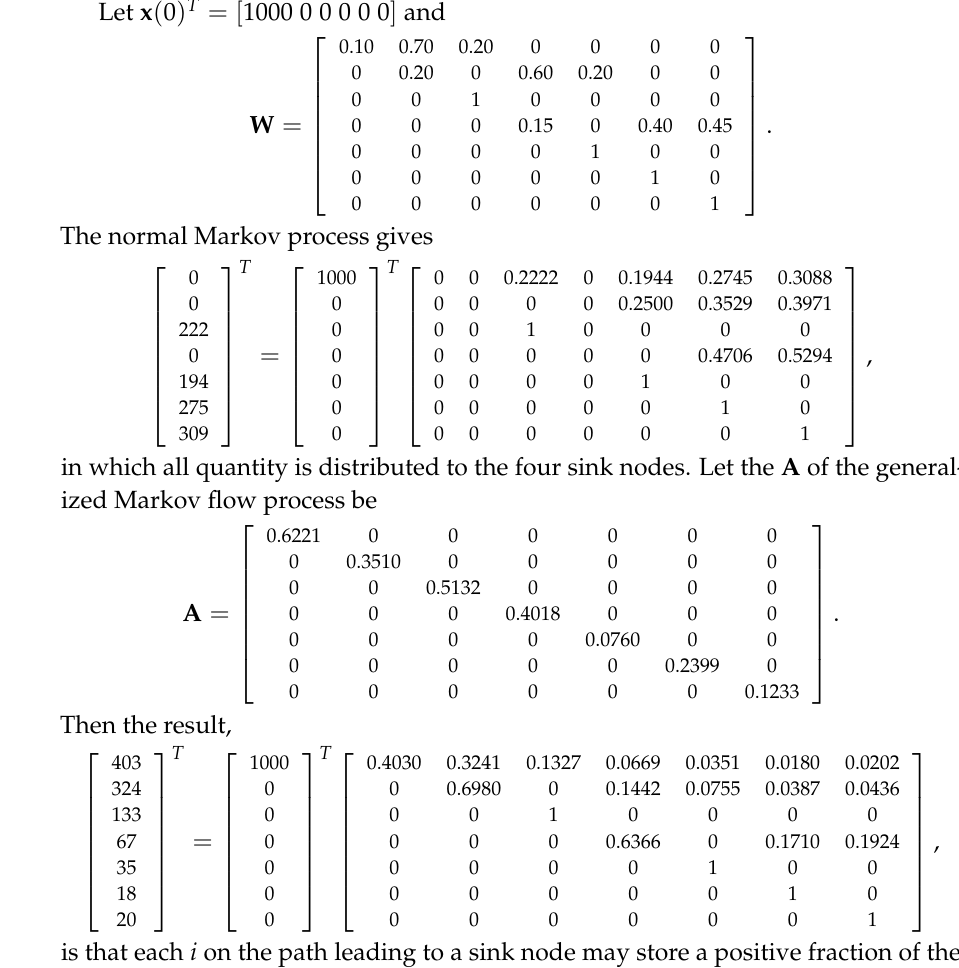
> 0 loops are not ii w ii